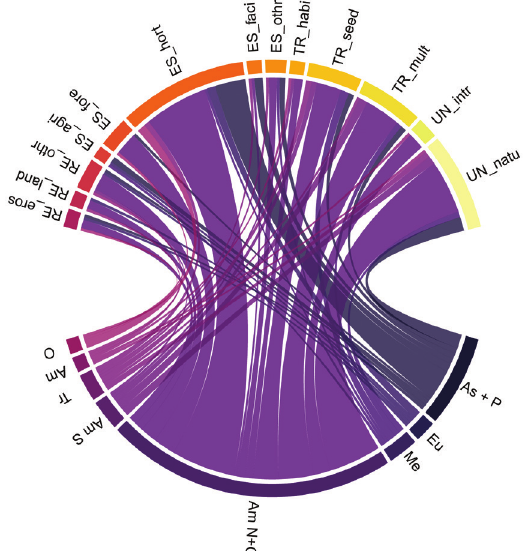
Figure 7. Proportion of invasive and potentially invasive alien plant species’ introductions by pathway and geographic origins (see Table 1 for